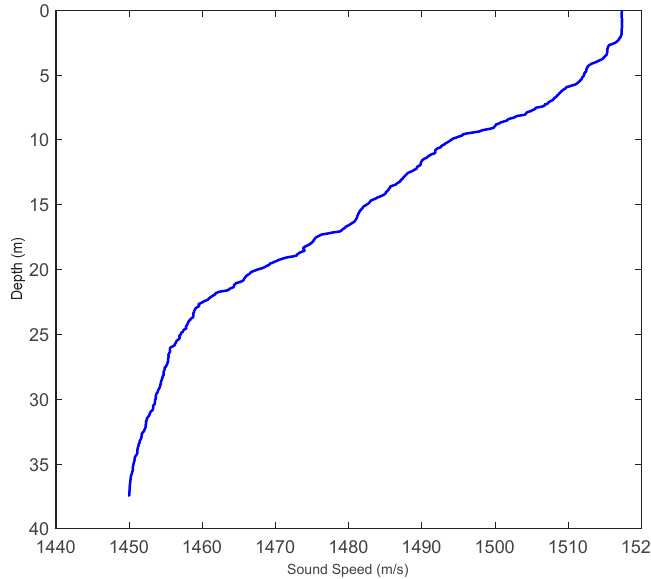
Figure 11. Underwater sound velocity distribution curve of a lake.